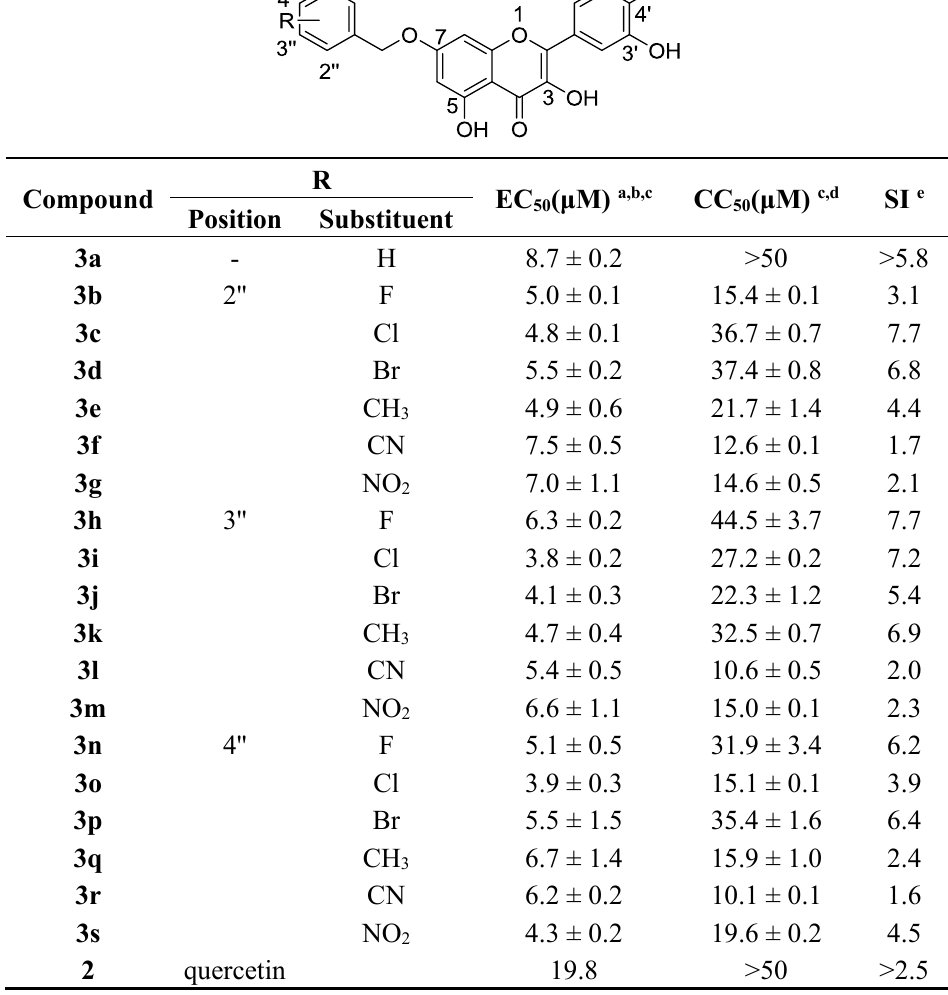
Table 1. Anti-HCV activities and cytotoxic effects of quercetin-7- O -substituted